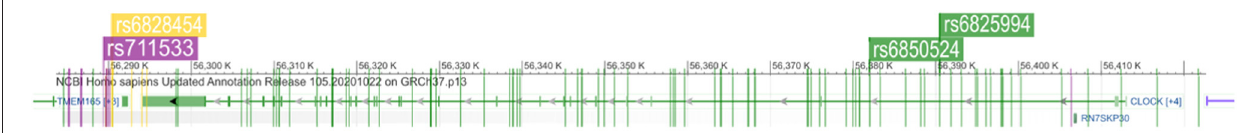
FIGURE 6 | Genomic location of significant SNPs identified in the clumping procedure, in the analysis of variation in CLOCK in interaction with recent life events and early childhood adversities on current depressive symptoms. In interaction with recent life events (RLE), our analyses identified one clump containing 94 SNPs with top SNPs rs6825994 and rs6850524 (for dominant and additive models, respectively) on current depressive symptoms (BSI-Dep), marked in green. In interaction with childhood adversities (CHA), two clumps, each with 9 SNPs and top SNPs rs6828454 and rs711533 were identified on current depression symptoms which are shown in yellow and purple, respectively. UCSC Genome Browser on Human Feb. 2009 (GRCh37/hg19) was used to visualize the location of polymorphisms on CLOCK